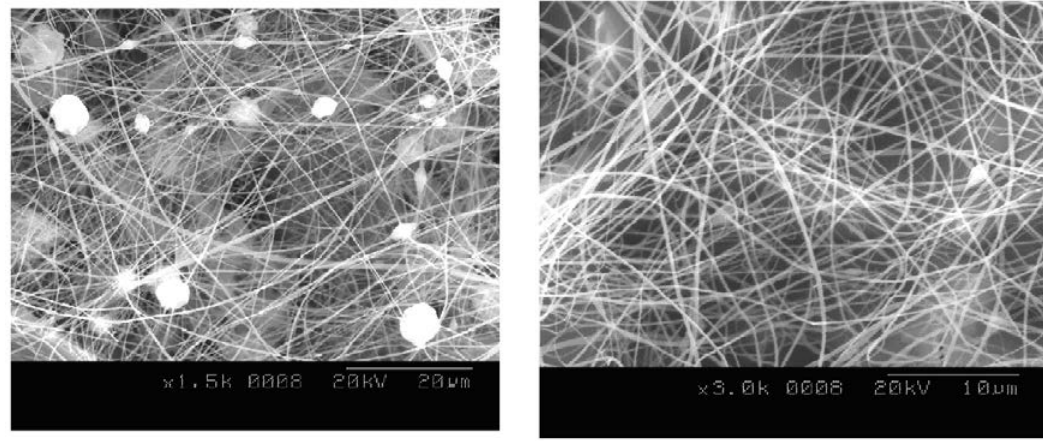
Figure 2. Nanofiber mats for: ( a ) poly(vinyl pyrrolidone) (PVP)/Ni acetate composite, ( b ) NiO after the calcination of PVP/Ni acetate composite at 700 °C, and ( c ) metallic Ni after the reduction of NiO with H 2.